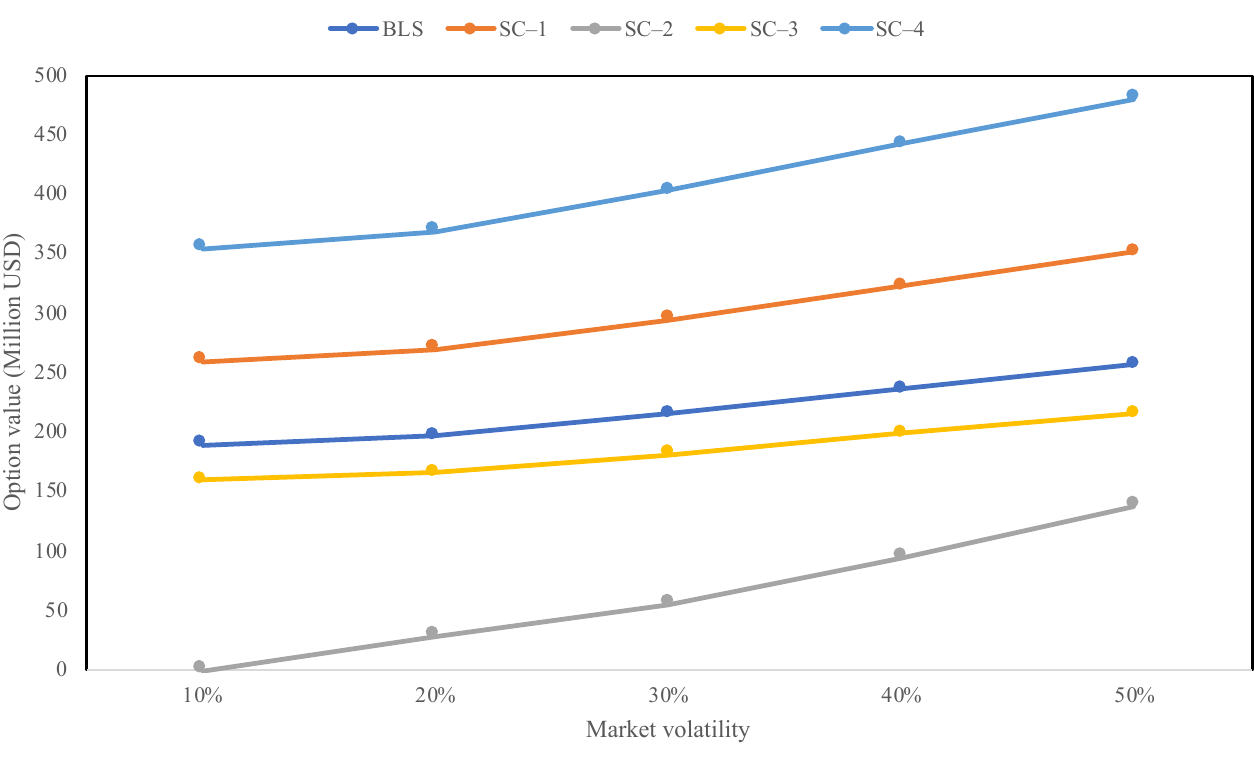
Figure 13. Option value sensitivity to increased market volatility.